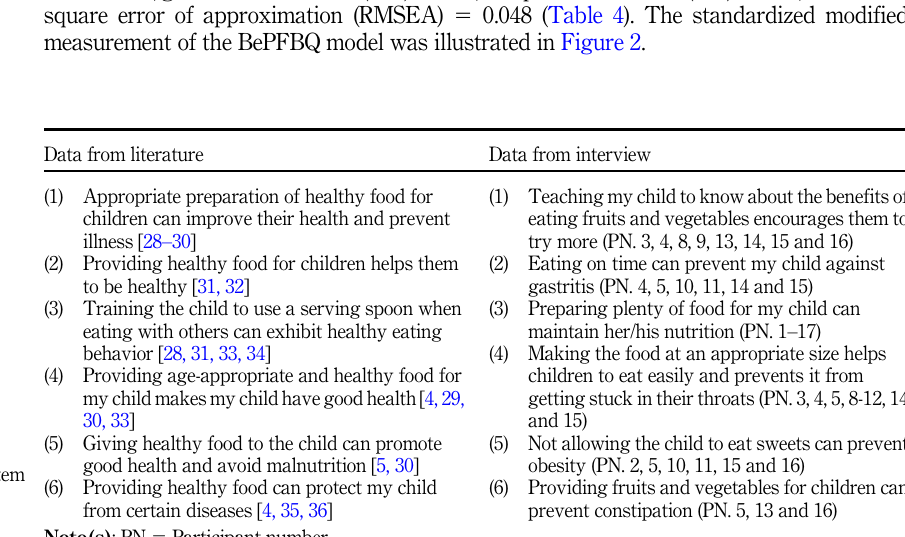
Table 2. Example data for item generation (from interviews and literature